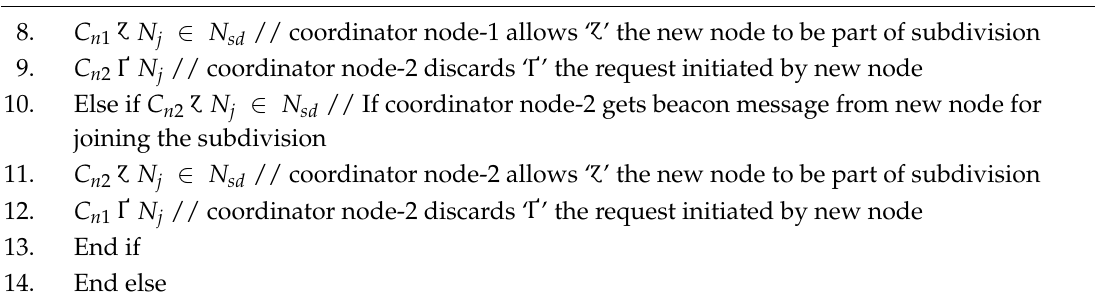
Table 2 shows the details of the notations used and their respective explanations.